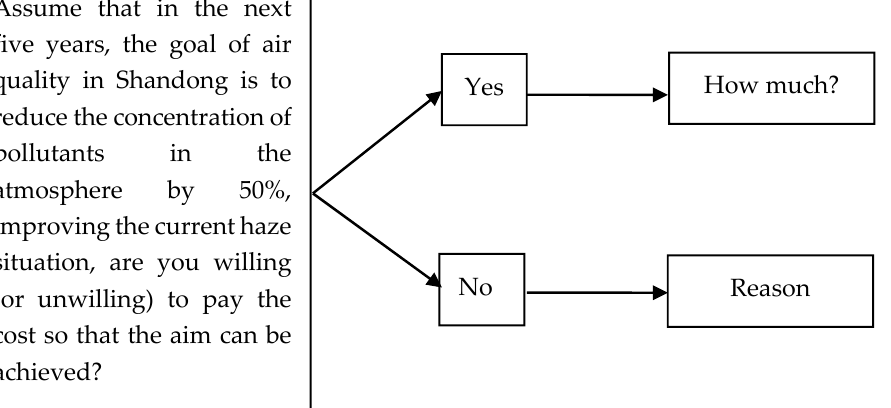
Figure 2. Main structure of the CVM survey.